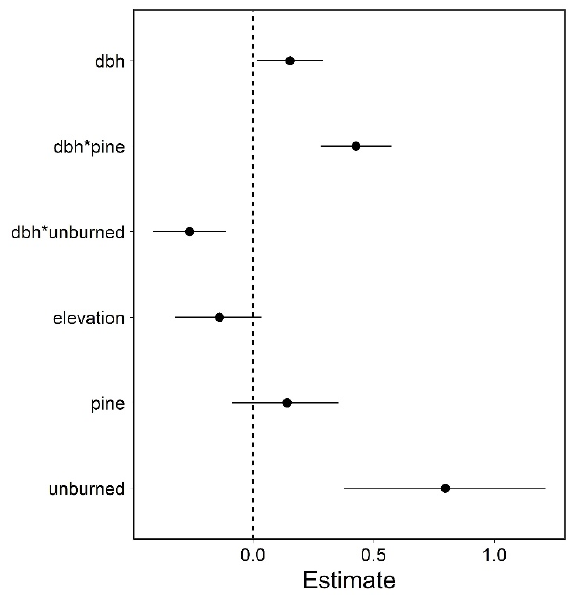
Figure 4. Model posterior median estimates and 95% credible intervals for probabilities of individ- ual tree mortality in burned and unburned plots at Sequoia and Kings Canyon National Parks. The fir species group and burned plots are the reference conditions used to compare against the pine species group and unburned plots. Terms for dbh*pine and dbh*unburned represent interactions. Observations for dbh and elevation were scaled to better allow comparisons among estimates.